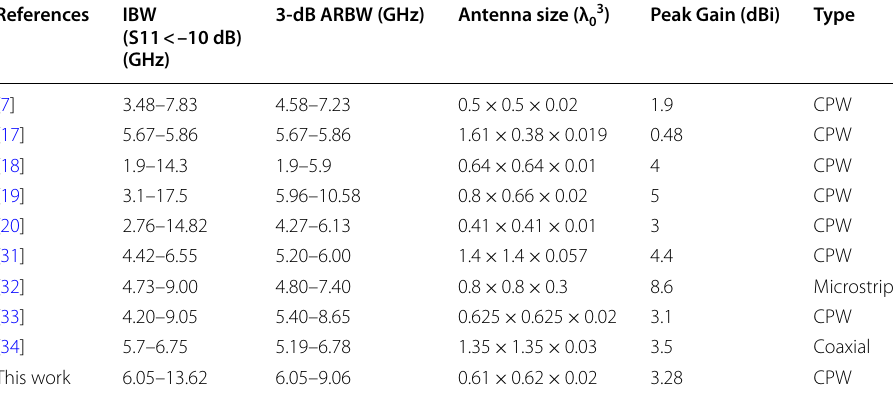
IBW impedance bandwidth, ARBW Axial ratio